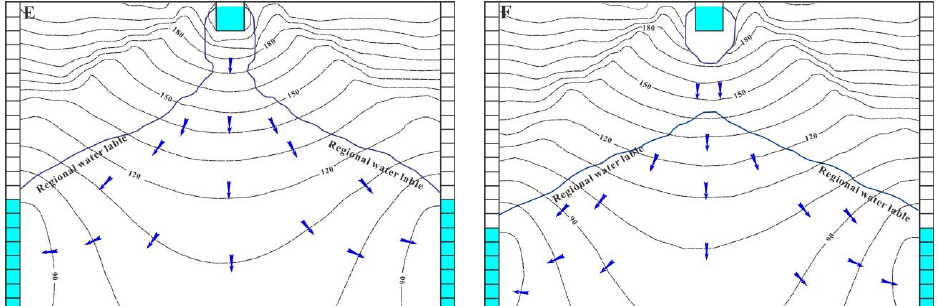
Figure 9. The change in the relationship between river water and groundwater in the sandbox experiment under the water-bearing medium sand A and a river water depth of 18.5 cm. Discharge water level ( A ): 200 cm, ( B ): 170 cm, ( C ): 140 cm, ( D ): 100 cm, ( E ): 80 cm, and ( F ): 60 cm.